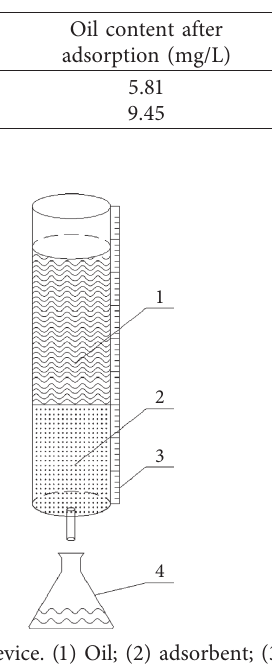
Table 6: Removal capacity comparison between pyrolytic carbon and activated carbon.